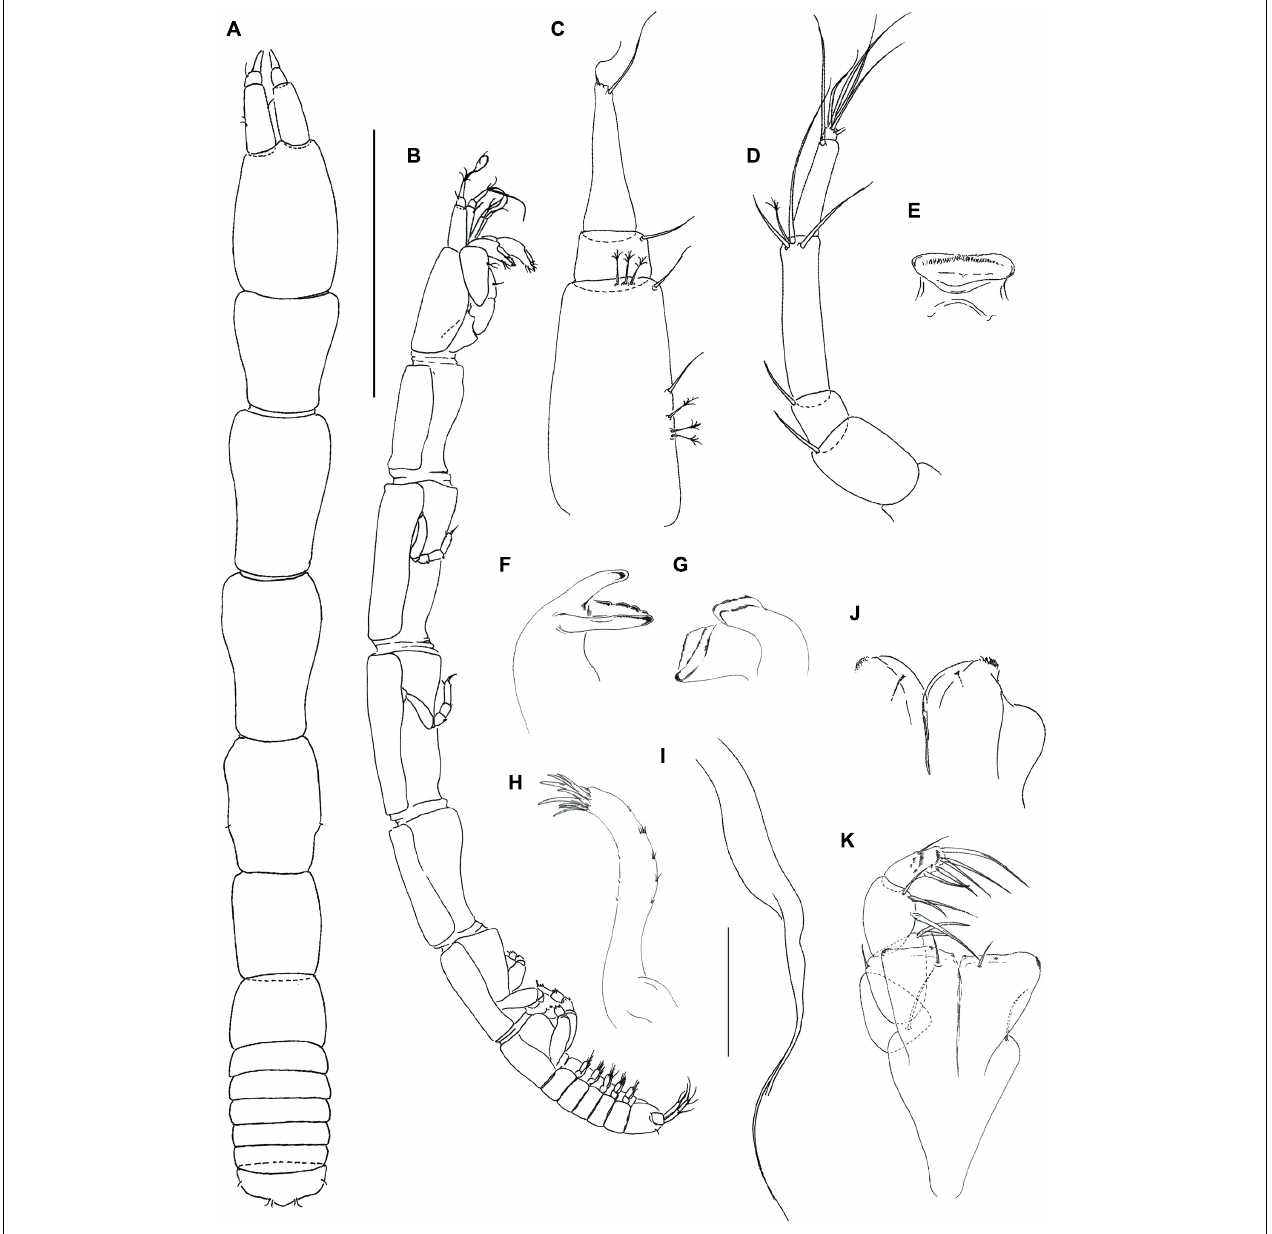
FIGURE 4 | Hamatipeda caipiroska n. sp. (MCZ 48350) (A,B) neuter; (C) antennule; (D) antenna; (E) labrum; (F,G) mandible left and right, respectively; (H,I) maxillule endite and palp; (J) , labium; (K) maxilliped. Scale: panels (A,B) = 1 mm, panels (C–J) = 0.1 mm.